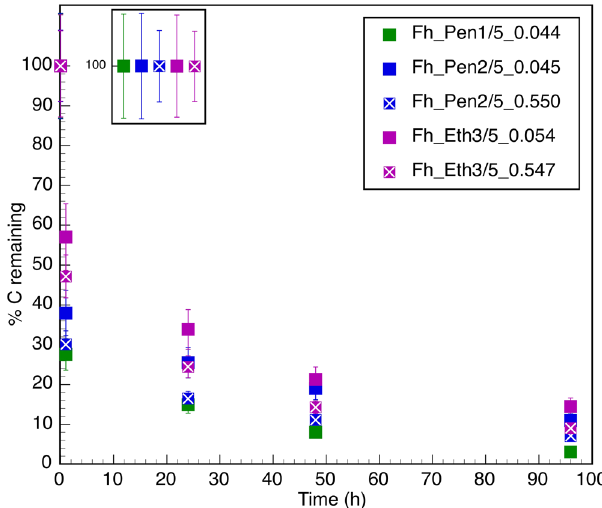
Fig. 5 Time series desorption of mono-, di- and tri-carboxylic acids coprecipitated with iron (oxyhydr)oxide ferrihydrite. Time series desorption data for carboxylic acid ferrihydrite coprecipitates plotted as time (h) vs. percent C remaining after exposure to 0.1 M NaOH. Green, blue and purple colour codes depict mono-, di- and tri-carboxylic data, as follows: solid square: Fh_Pen1/5, Fh_Pen2/5 and Fh_Eth3/5